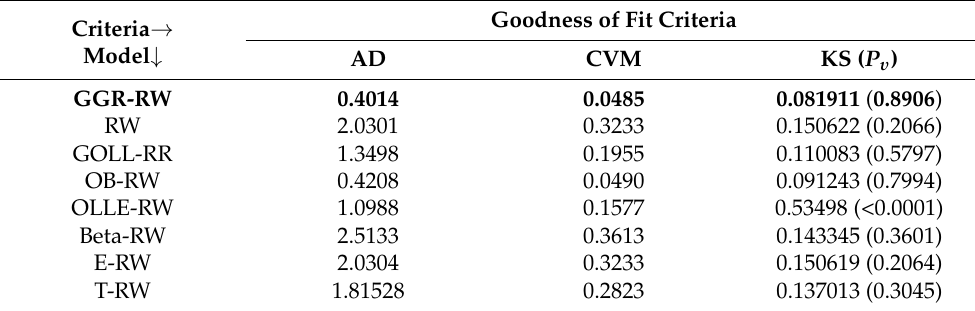
Table 6. CVM, AD, KS and P υ for the relief times data.